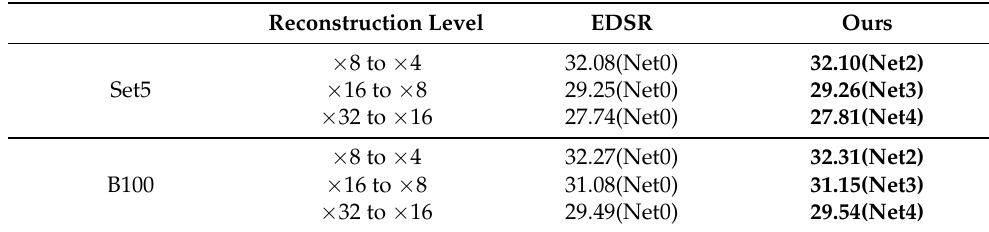
Table 4. The PSNR values of intermediate results generated by model reconstruction at different levels of EDSR method and our